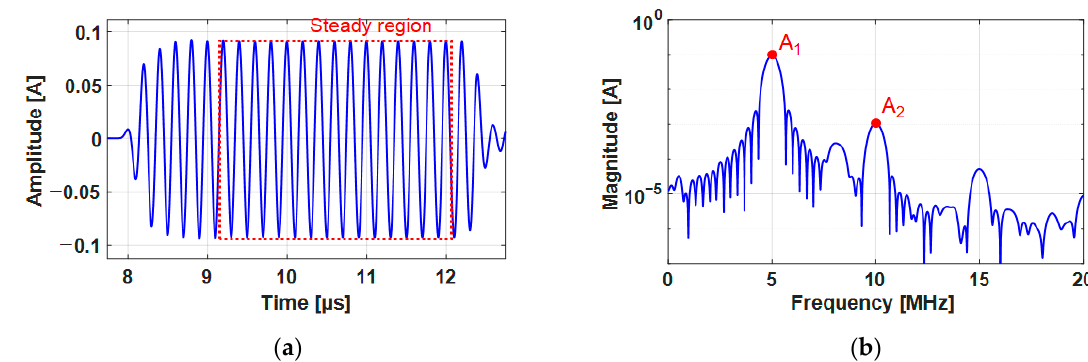
Figure 12. Transfer functions of the receiving transducer ( | H( ω ) | ) following from the calibration measurement after diffraction correction: ( a ) fused silica and ( b ) Al6061-T6.